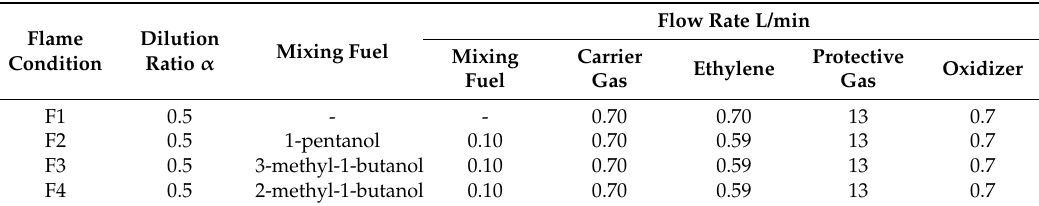
Table 2. Experimental conditions of the different blended